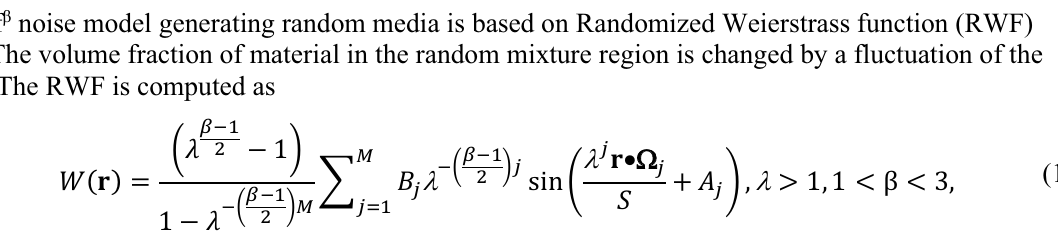
with the 1/f β noise eff